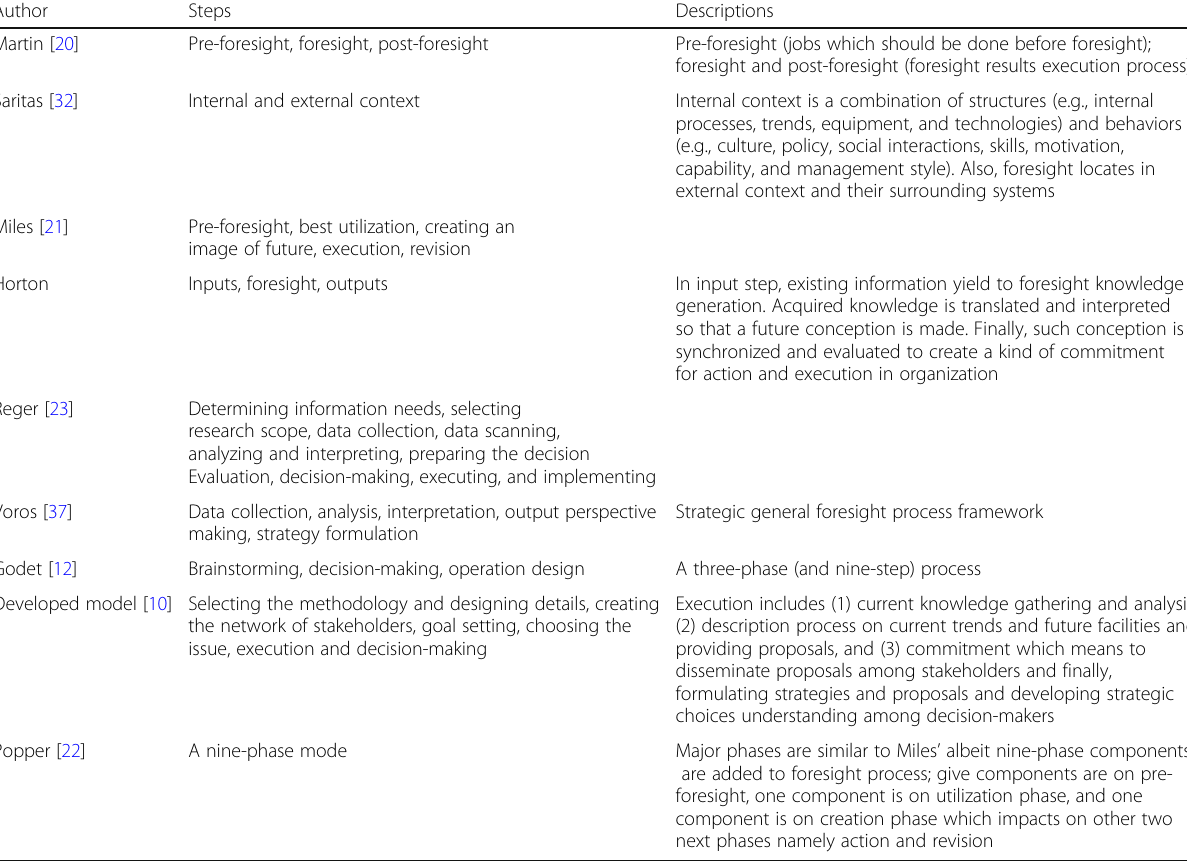
Table 1 Foresight common